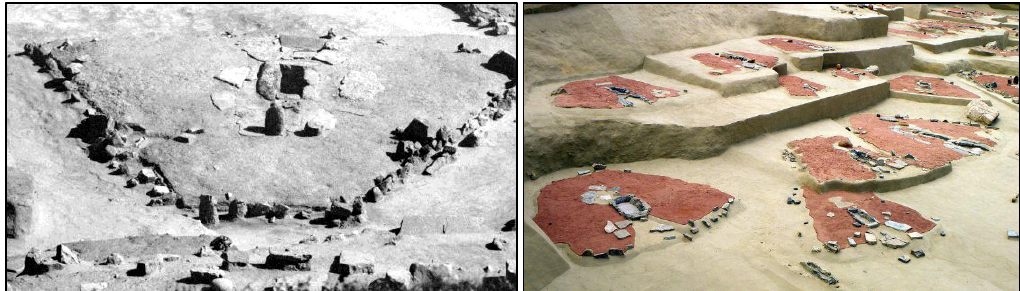
Figure 22. Plan of the constructive base of a typical dwelling in Lepenski Vir. The modularity of the building is very easy to see. It significantly simplifies construction for builders and greatly shortens the time needed for this. The most characteristic thing in this drawing is the incitement of two opposing walls. Namely, to be as simple as possible, one should have as few walls as possible, and here are only two walls in question. They cut at an angle of 60 degrees. The cross-section of these two walls at a sharp angle is difficult and impractical to perform, especially because this side of the building is buried. The entrance is the only open part on the building and accordingly, it is difficult to completely isolate the house. As light and heat enter the house with the sun, it is best to leave the entrance open to the river and to the light. And in order to increase the space as much as possible, both physically and psychologically, a semi-circular wall was introduced beside fireplaces, an incredibly simple and fantastic practical solution.